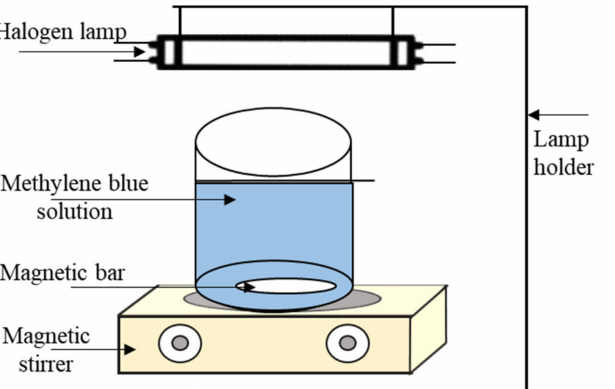
Figure 3. A schematic diagram of the photocatalytic activity test